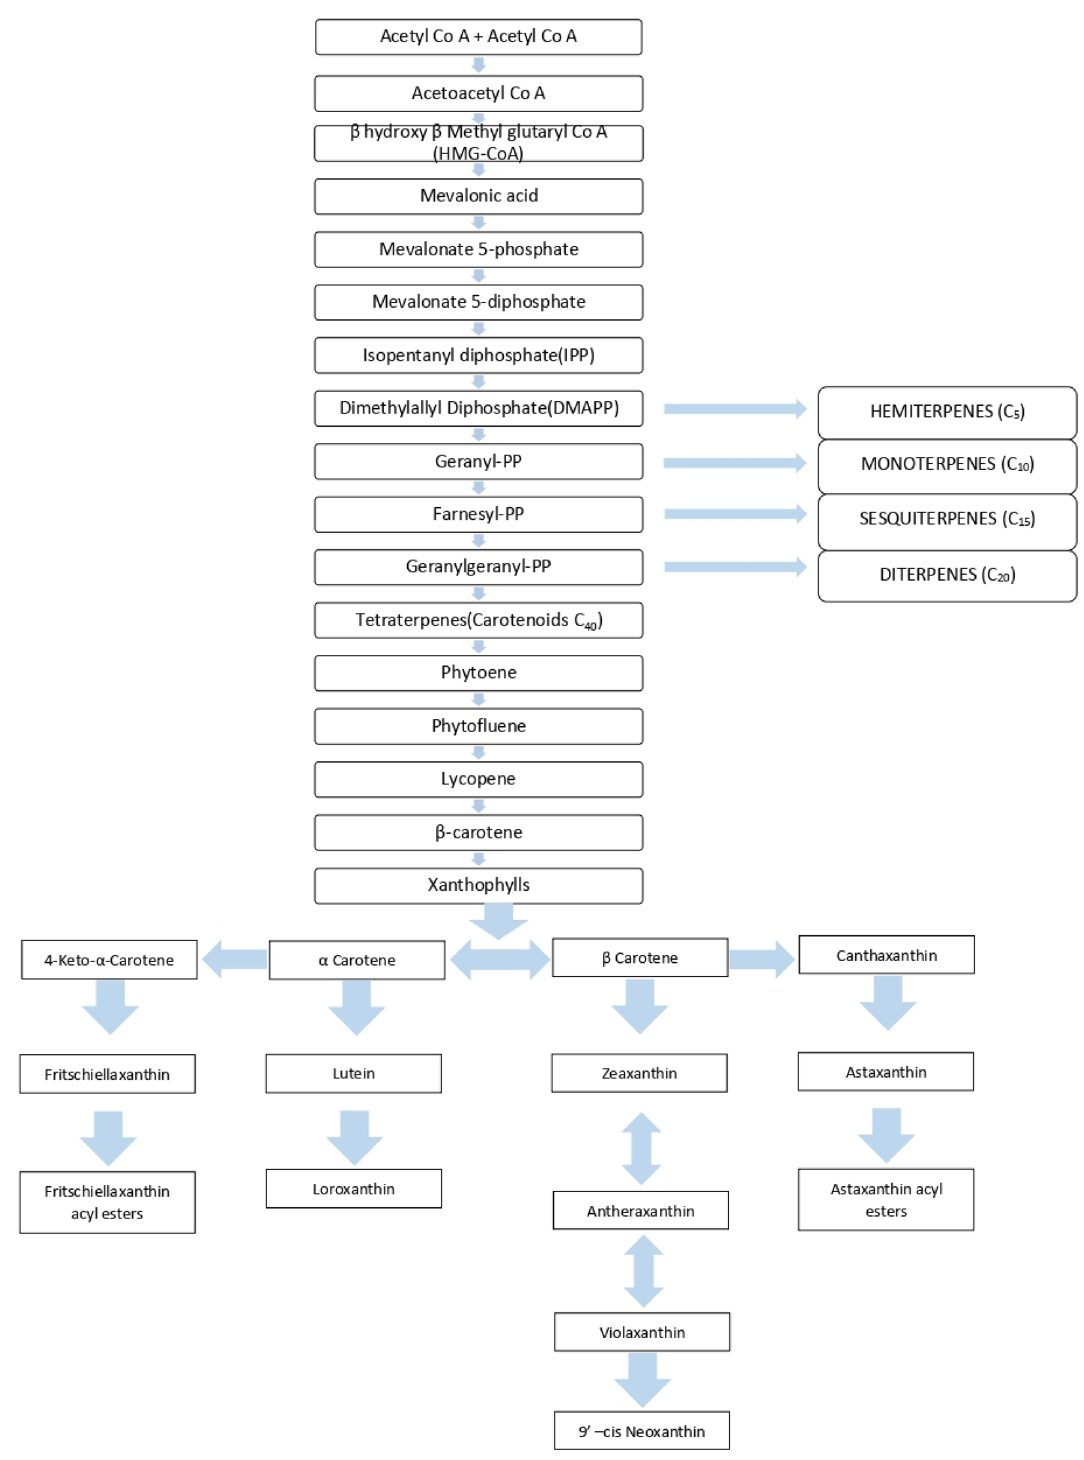
Fig. 1 Biosynthesis pathway of carotenoids [1,